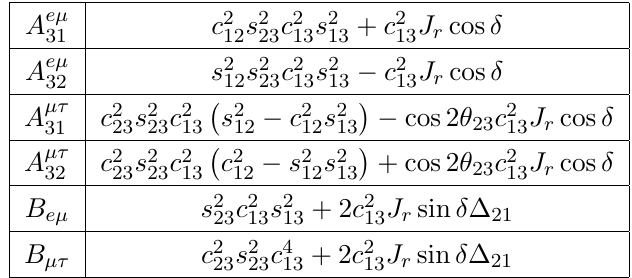
. See e.g., ref. [28]. 31